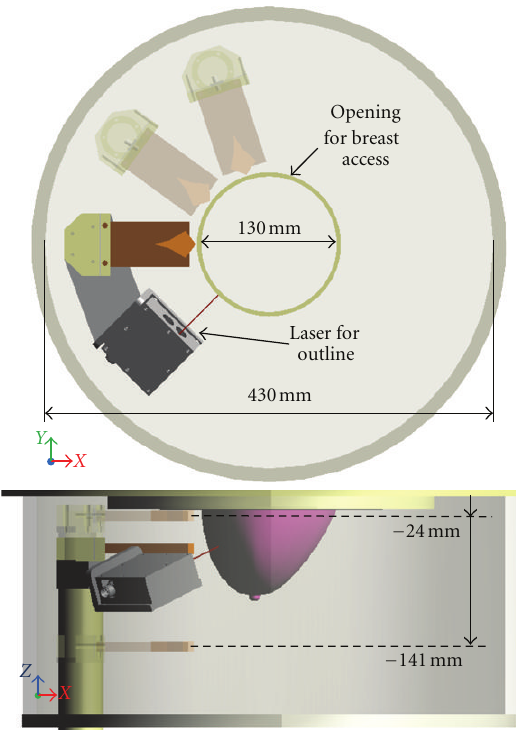
Figure 2: Top and side views of the TSAR prototype system tank with dimensions. Additional antenna locations are shown (shaded antenna body) to illustrate the tank rotation and arm movement. For better clarity, the laser is not shown for the additional antenna